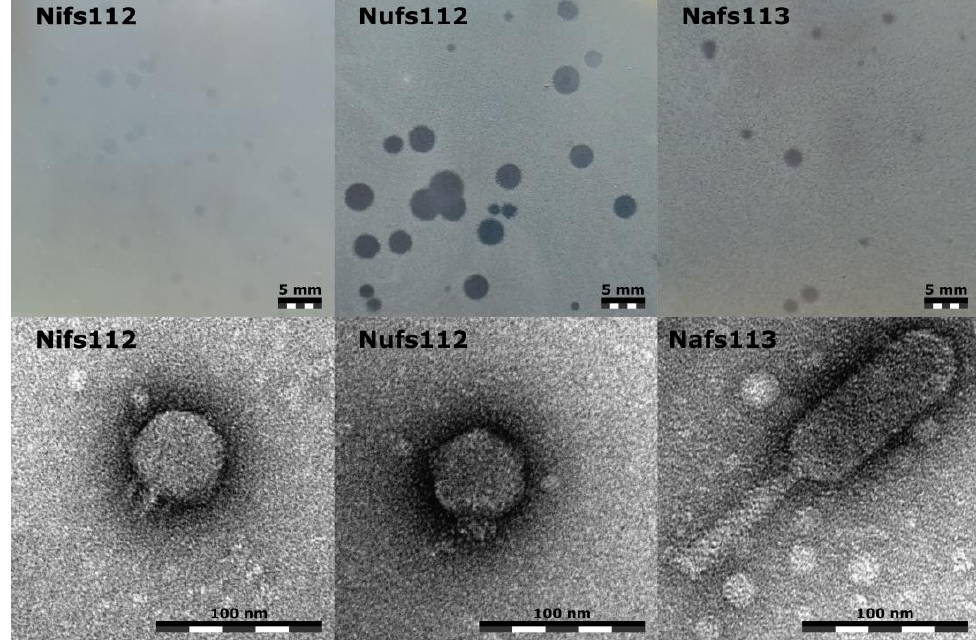
Figure 2. Plaque ( upper row) and virion morphologies ( lower row) of the studied Pantoea phages Nifs112, Nufs112, and Nafs113. Plaques were photographed after incubation for ~24 h at room temperature using P. agglomerans LS5-2 culture for the lawn and the same double agar overlay plating conditions; the scale bar represents 5 mm. Representative virion micrographs were obtained from the corresponding phage purified lysates negatively stained with 0.5% uranyl acetate; the scale bar represents 100 nm.